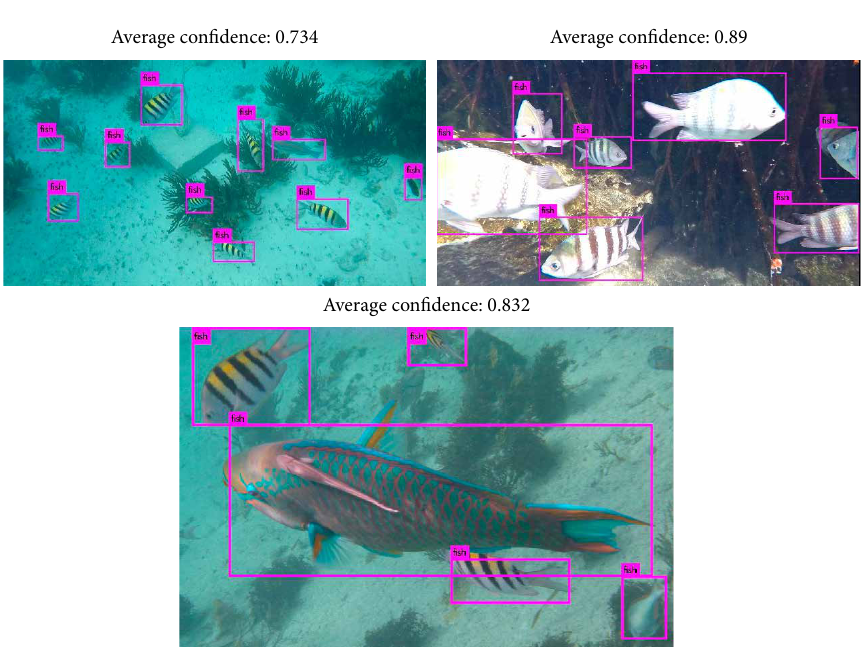
Figure 20: Enhancement of identification accuracy with the refinement of loss